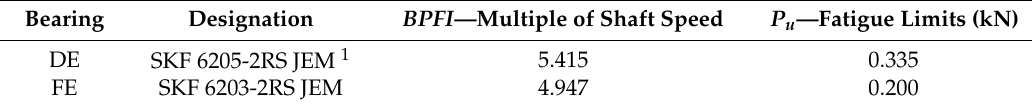
Figure 1. Case Western Reserve University (CWRU) bearings test apparatus [38,55]. Table 1. Bearing specifications.